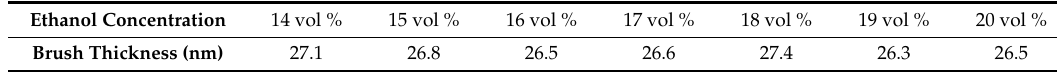
Table A2. Raw data of swollen brush thickness of a PNiPAAm brush plotted in Figure 1d.